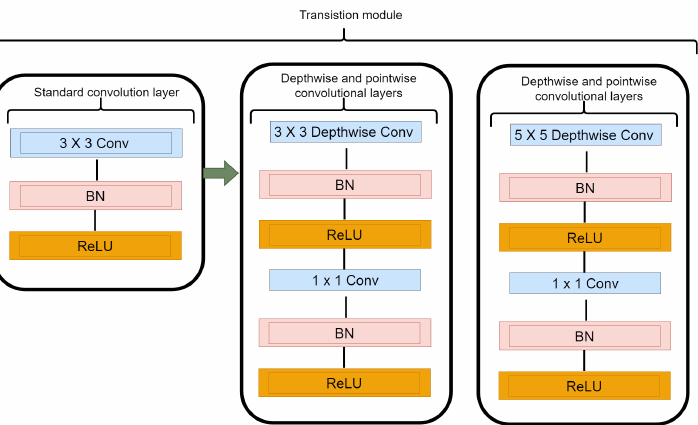
Figure 5. Transition of regular convolution to depthwise separable convolution module for both 3 × 3 and 5 × 5 depthwise